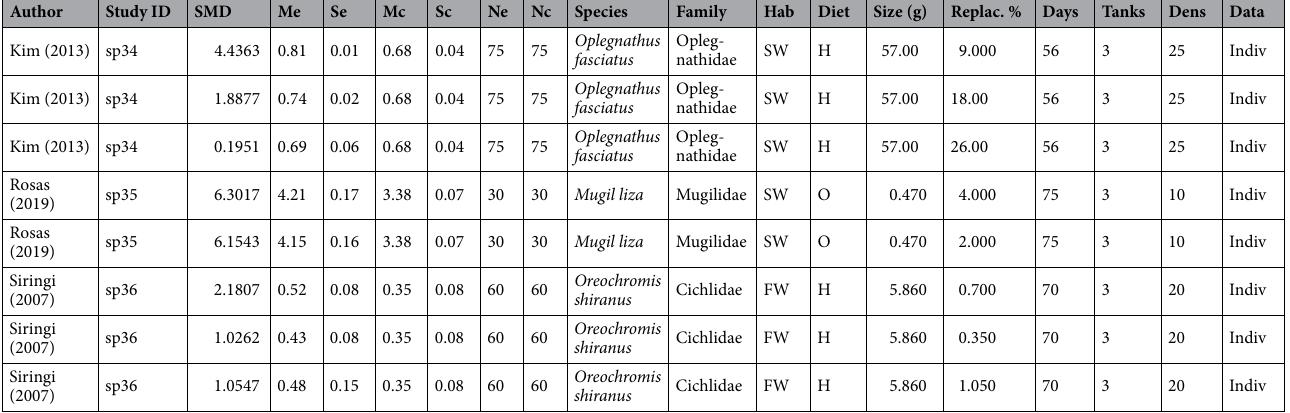
Table 1. Results of feeding studies assessing the effects of Spirulina replacement on Specific Growth Rate (SGR, %) of farmed fish. SMD standardized mean difference, Me mean SGR of experimental group, Se standard deviation of SGR of experimental group, Mc mean SGR of control group, Sc standard deviation of SGR of control group, Ne sample size of experimental group, Nc sample size of control group, Hab. FW freshwater, SW sea water, Diet Carnivore (C), Herbivore (H), Omnivore (O), Size initial mass (g), Replac. % Spirulina replacement level (%), Days duration of trial (days), Tanks number of replicate tanks, Dens. tank density (No. fish/tank), Data type of measurement (individual weights or batch